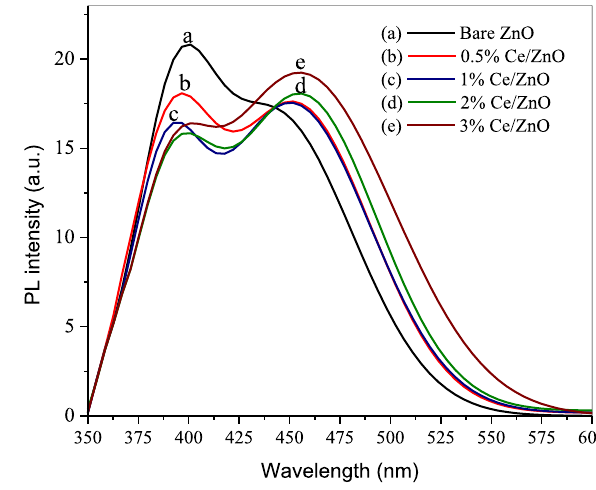
Fig. 5 UV–Visible spectra and Kubelka–Munk plots (inset) of a , f bare ZnO, b , g 0.5%Ce/ZnO, c , h 1%Ce/ZnO, d , i 2%Ce/ZnO and e ,